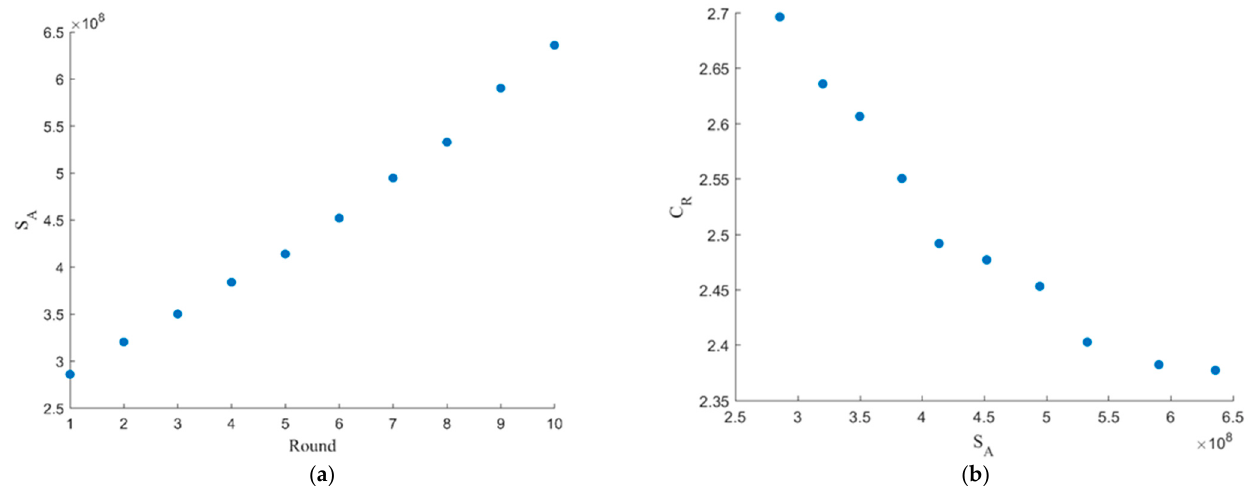
Figure 12. Scatter plots of m rounds compared to the S A value of the encrypted DEM B and that of C R compared to the S A values.